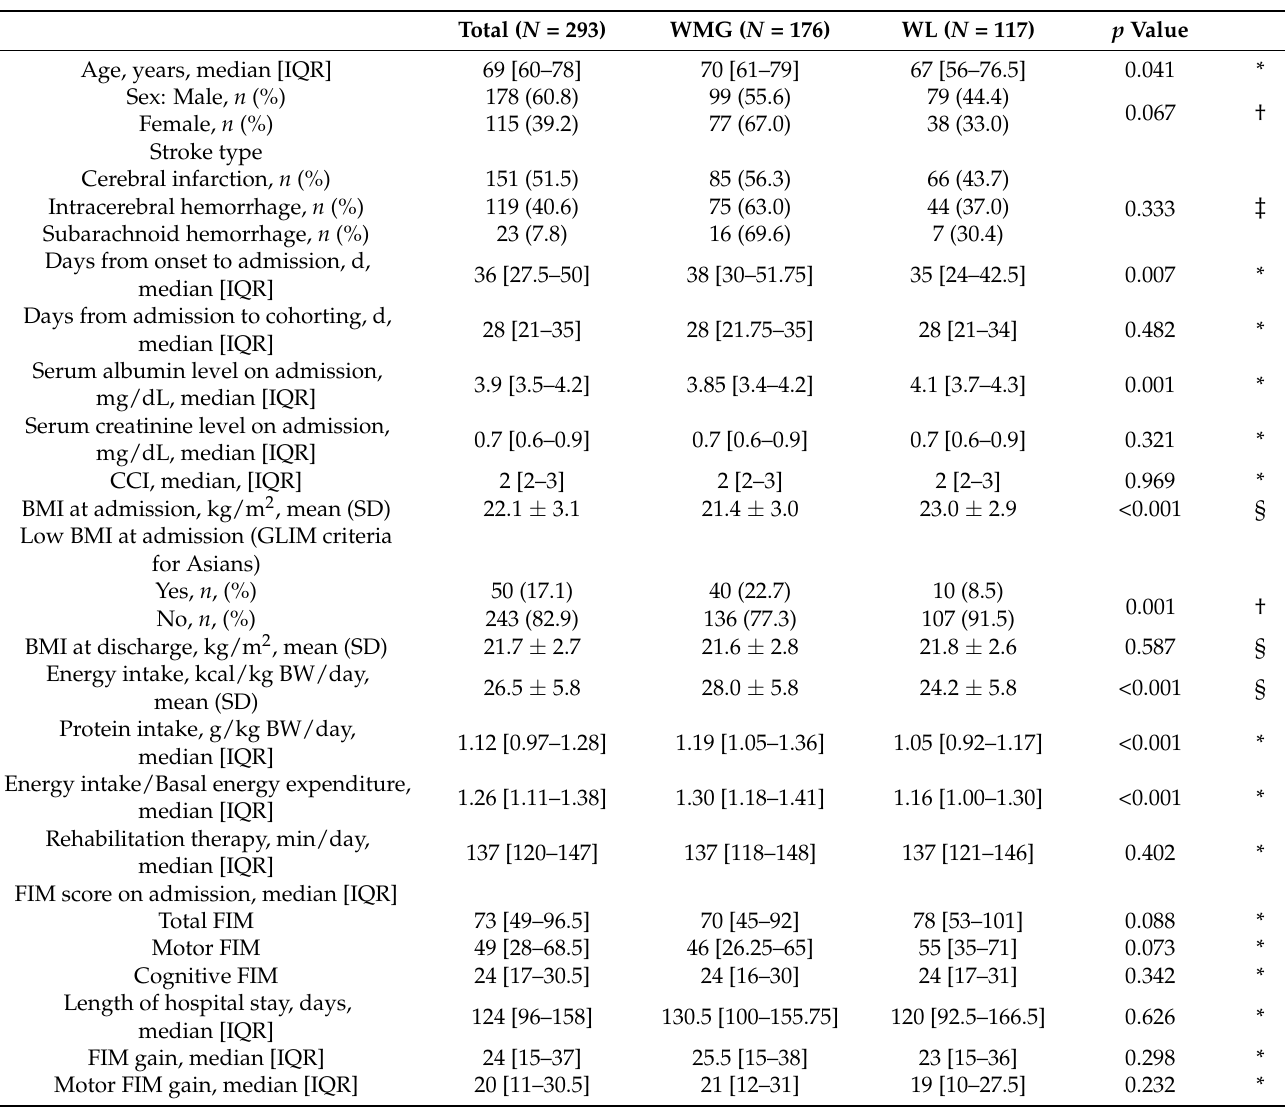
Figure 1. Study flowchart. Table 1. Patients’